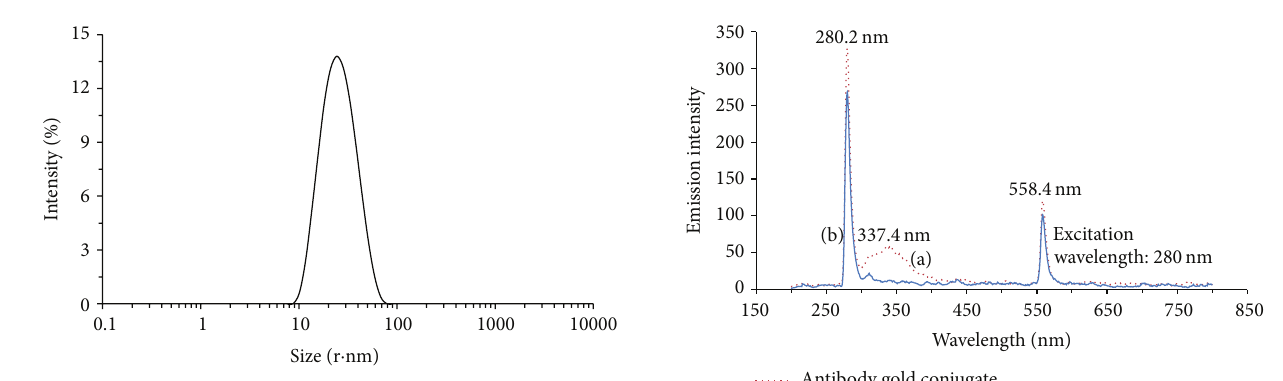
Figure 4: Dynamic light scattering spectrum of colloidal gold nanoparticles.